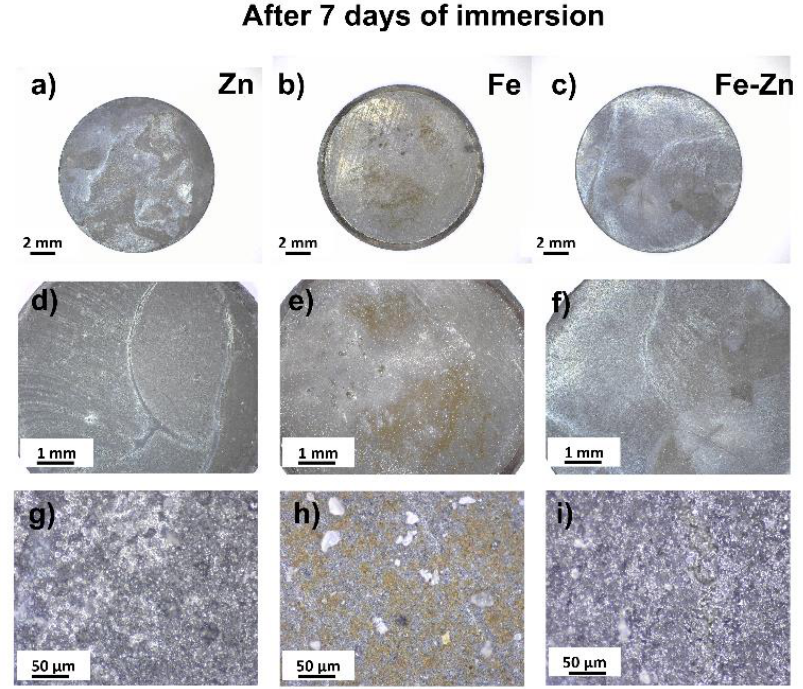
Figure 6. Optical photographs of corroded Zn ( a , d , g ), Fe ( b , e , h ) and Fe-Zn ( c , f , i ) samples after 7 days of immersion in simulated body fluids (Hanks´ solution at 37 ± 2 °C, pH = 7.4 ± 0.2).